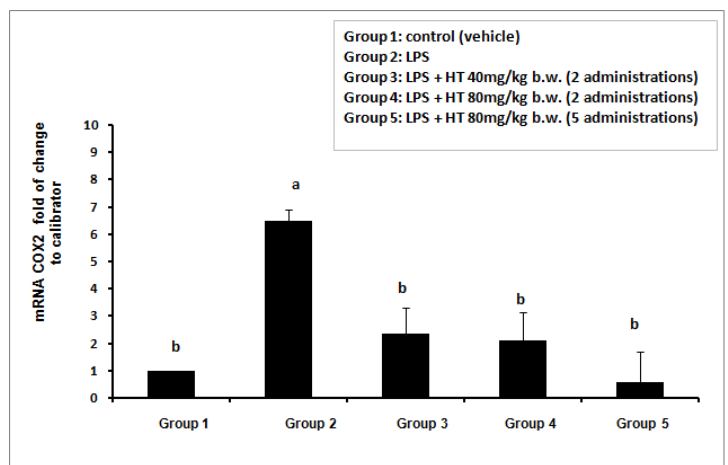
Figure 1. Effect of HT on LPS-induced COX2 gene expression (mRNA) evaluated by qPCR in mice. Total RNA was extracted from 100 µL of blood opportunely stored. Data represent the increment of COX2 mRNA in respect to calibrator (vehicle group). Each bar represents the mean ± S.D. of values obtained from the 8 mice / group. Bars with a different letter are significantly different, p < 0.05.